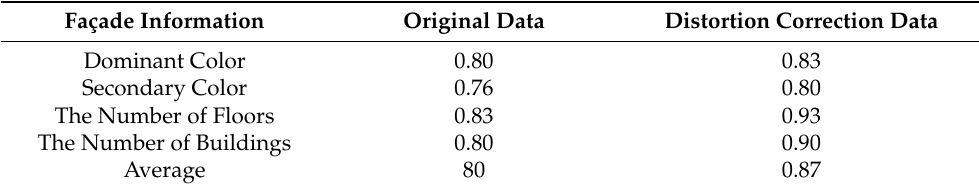
Table 13. Façade information accuracy of original and distortion correction data.